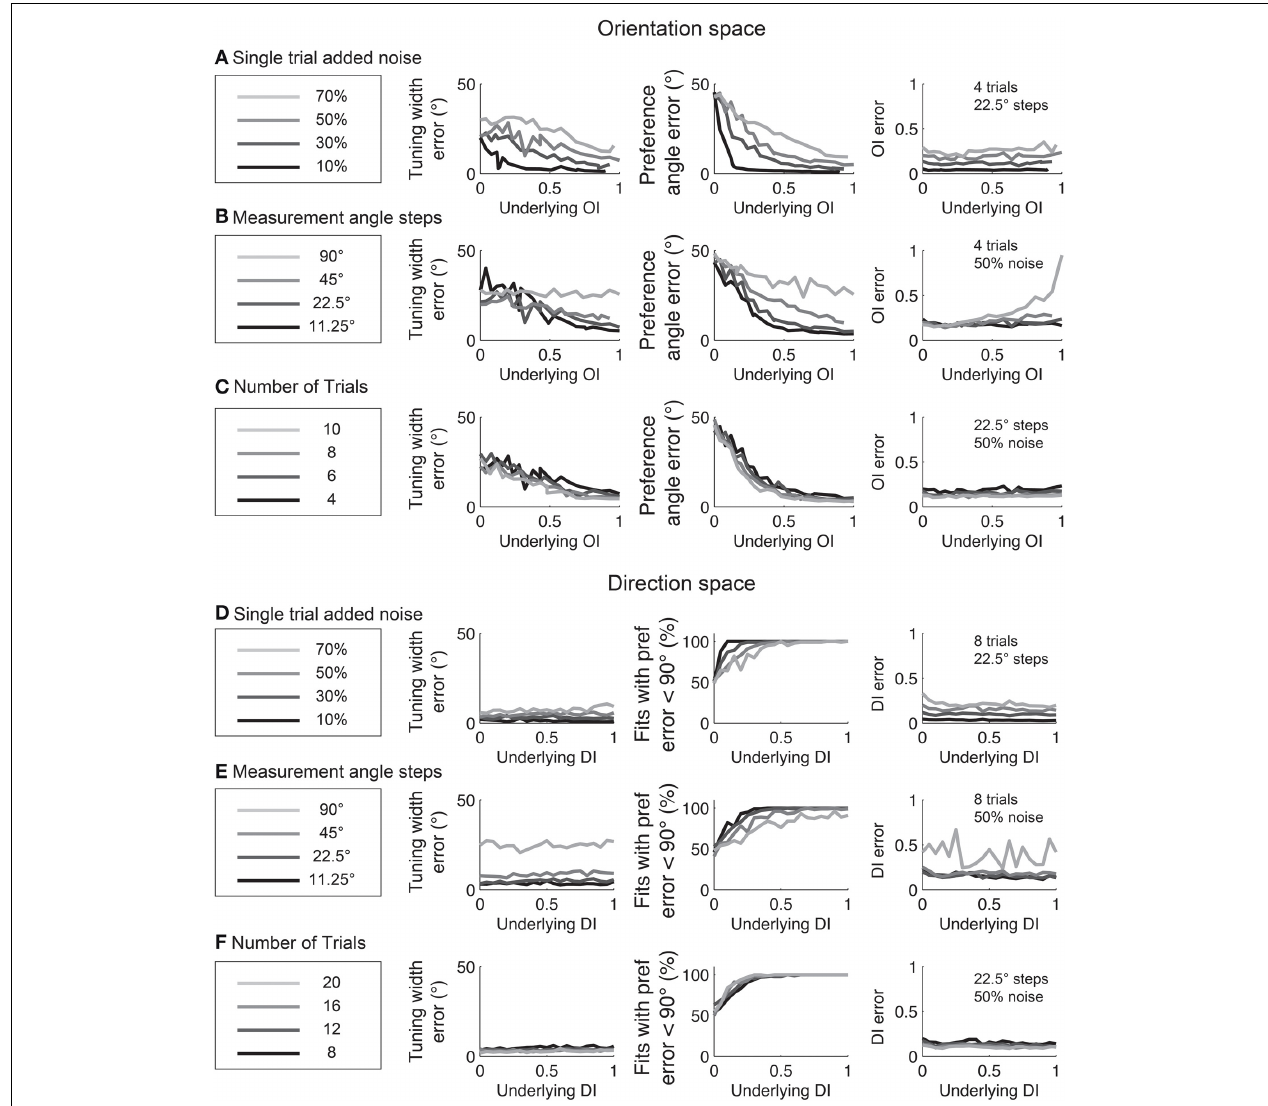
FIGURE 12 | The dependence of errors in identifying tuning width, preference angle, and OI / DI on neural noise and stimulus sampling. On the Y axis of all plots is the median error between the “true” underlying quantity and the value provided by the fit. (A–C) are in orientation space, and (D–F) are in direction space. (A,D) Dependence of error on single trial noise